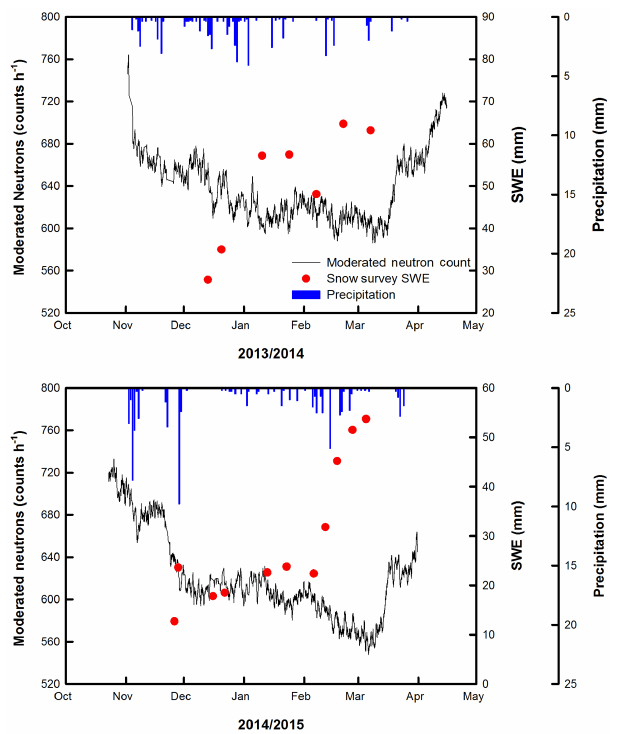
Figure 2. Moderated neutron intensity and snow survey SWE for 2013/2014 (top) and 2014/2015 (bottom). Precipitation sourced from SRC site and represents daily